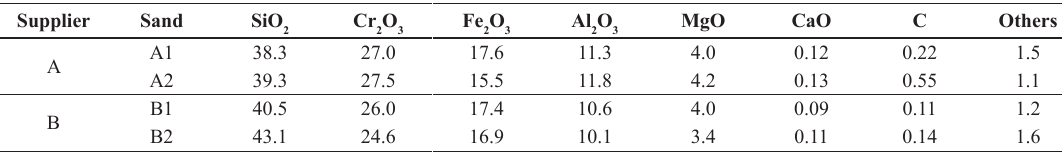
Table I. Filler sands chemical composition.